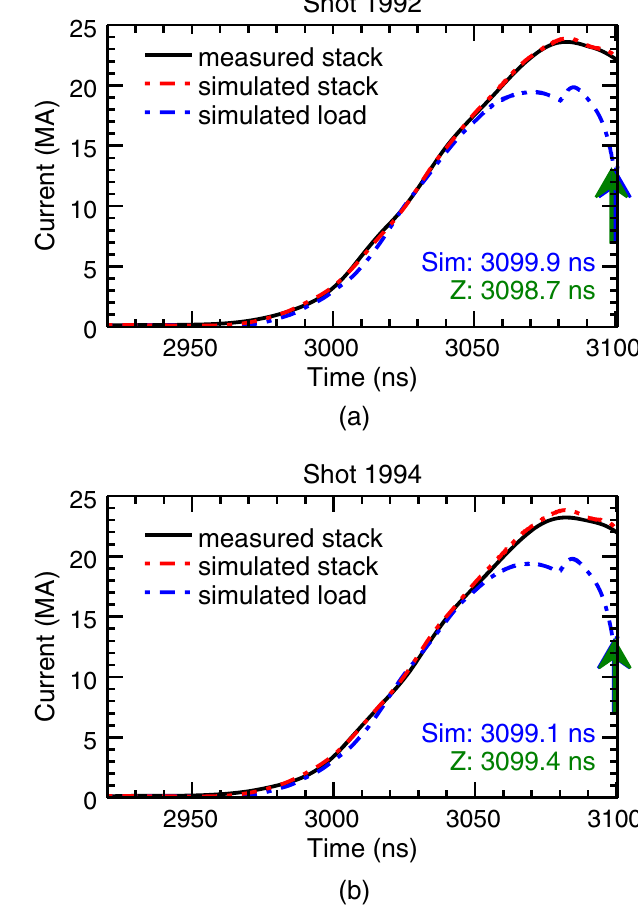
FIG. 9. Comparison of simulation and experiment results of two nested tungsten wire-array shots [20]. (a) Z shot 1992, (b) Z shot